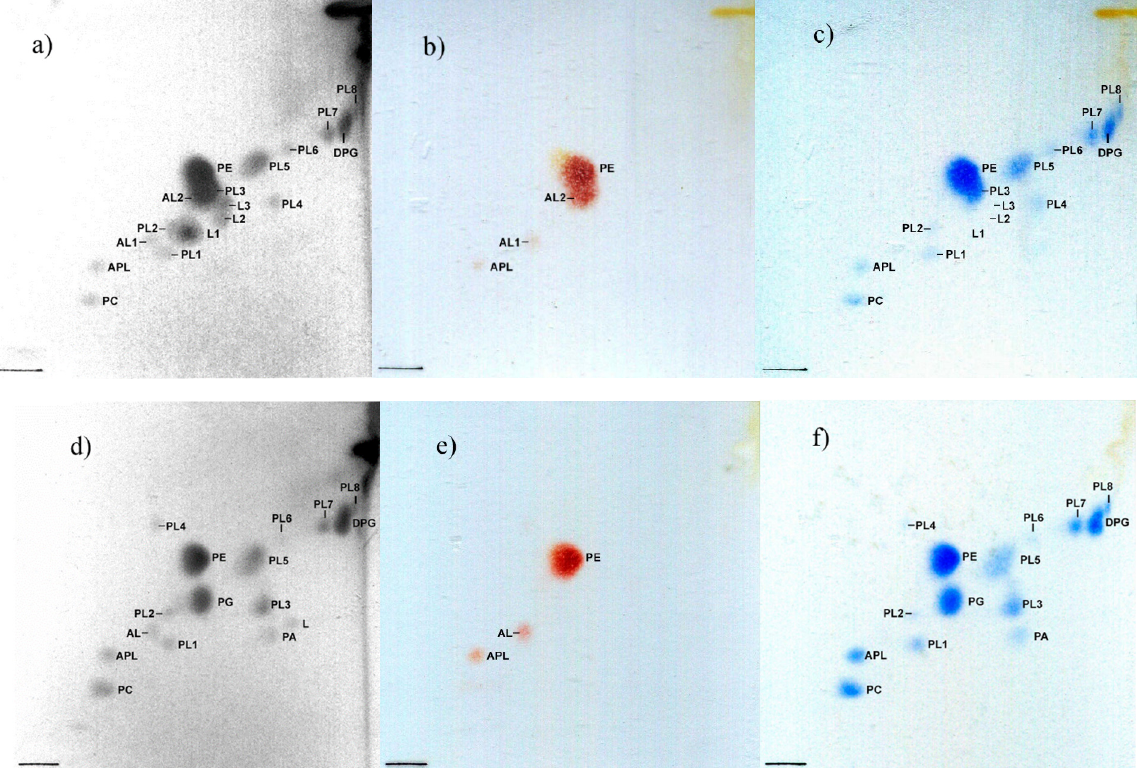
Figure 4. Two-dimensional thin-layer chromatograms of polar lipids of strains: ( a – c ) KMM 9957 T ; ( d – f ) Marinobacterium aestuarii KCTC T . ( a , d ), non-specific detection of lipids prepared with 10% H 2 SO 4 in methanol; ( b , e ), stained with ninhydrin; ( c , f ), stained with molybdate reagent. Abbreviations: PC, phosphatidylcholine; PG, phosphatidylglycerol; PE, phosphatidylethanolamine; DPG, diphosphatidylglycerol; APL, an unidentified aminophospholipid; PA, phosphatidic acid; PL1-PL8, unidentified phospholipids; AL, AL1, AL2, unidentified aminolipids; L, L1, L2, L3, unidentified lipids.